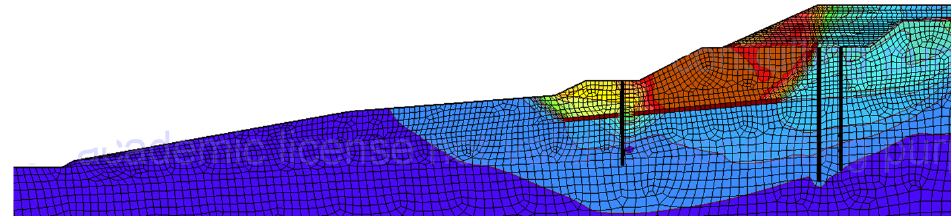
Figure 15. Potential sliding surface after reinforcement.